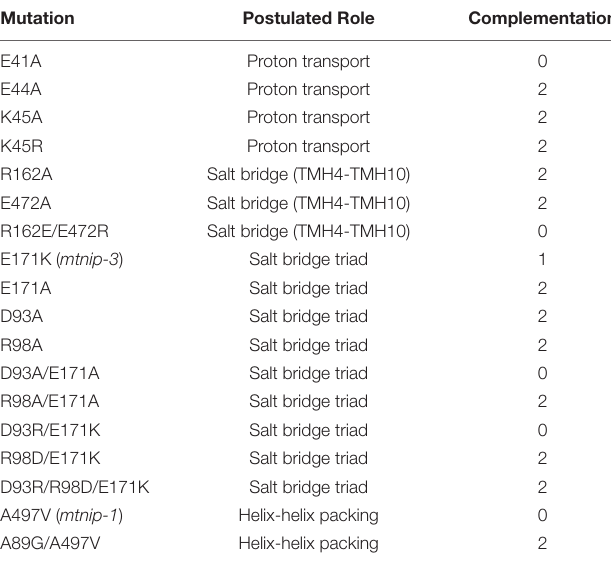
TABLE 1 | List of mutants used for in planta complementation studies, their postulated role, and complementation results with 0 = no complementation, 1 = partial complementation, 2 = full